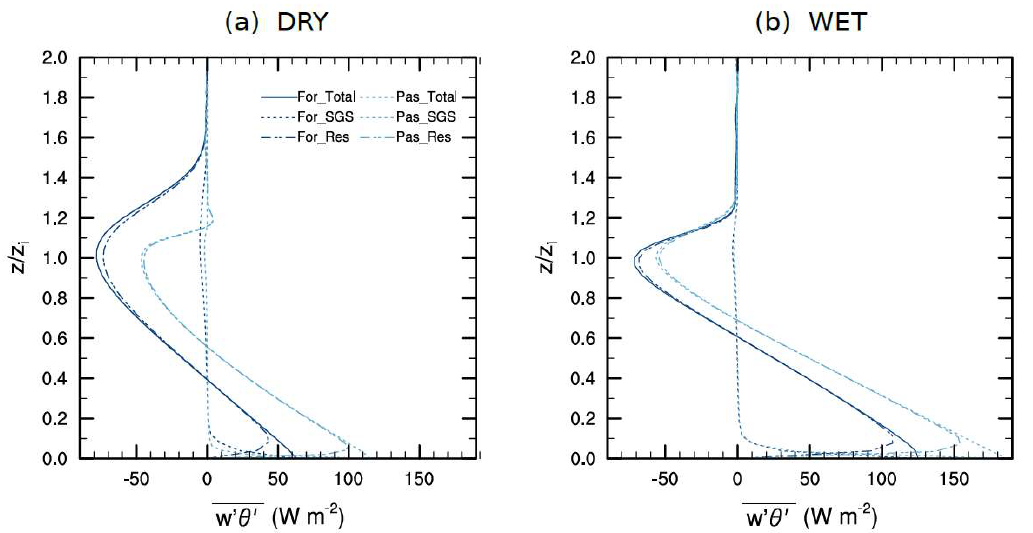
Figure 4. Vertical profiles of turbulent thermal flux for FOR (Dark blue) and PAS (Light blue) sites at 14:00 LT for DRY ( a ) and WET ( b ) period. The LES profiles are domain- and time-averaged. The boundary layer height zi is defined as the height where the minimum negative value of buoyancy flux is located, and so the vertical scale of each profile is normalized by its own zi in each case.